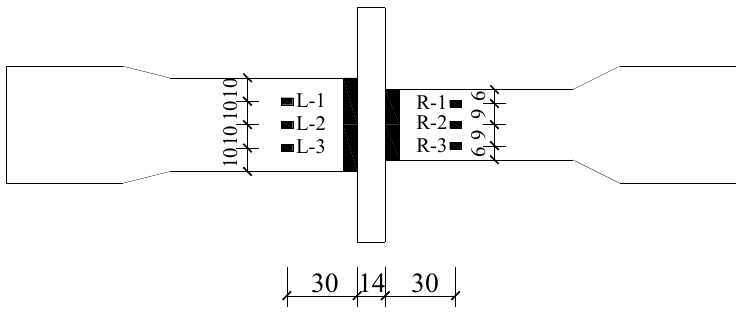
Figure 5. Layout of measuring points (mm).